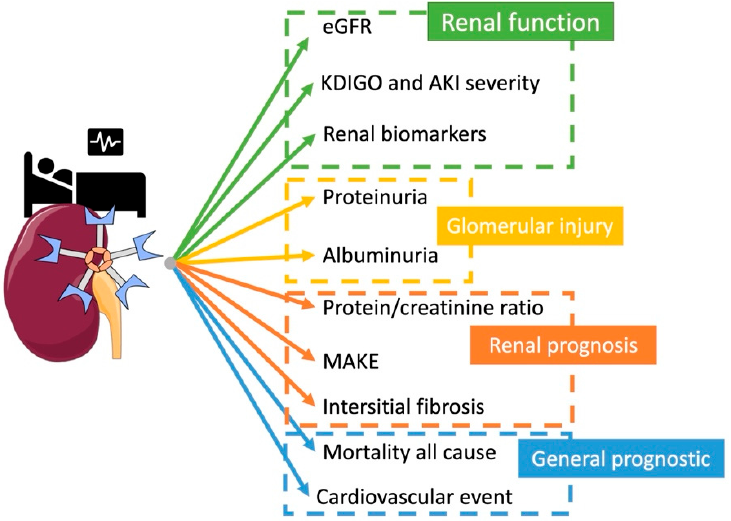
Figure 4. Kidney galectin-3 association with outcome in clinical studies.